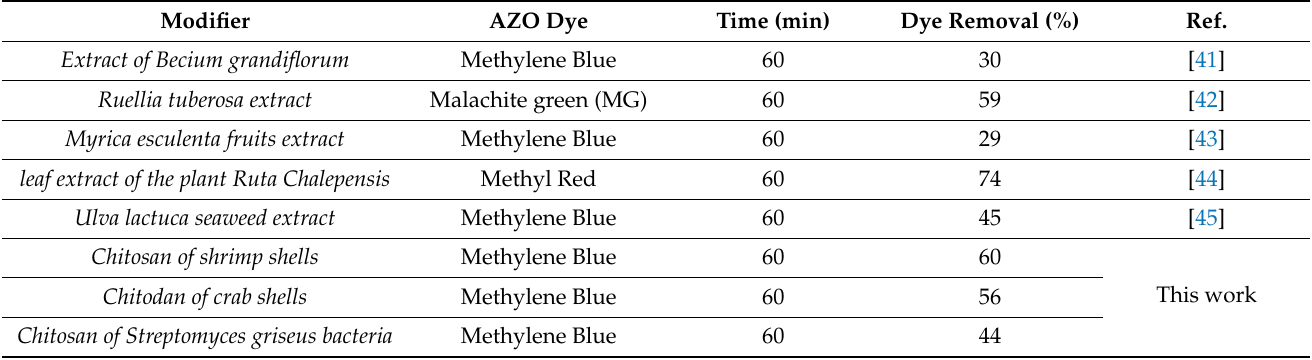
Table 4. The comparison of results of the AZO dye removal efficiency of ZnO NPs prepared from different growth controlling agents compared to this work.